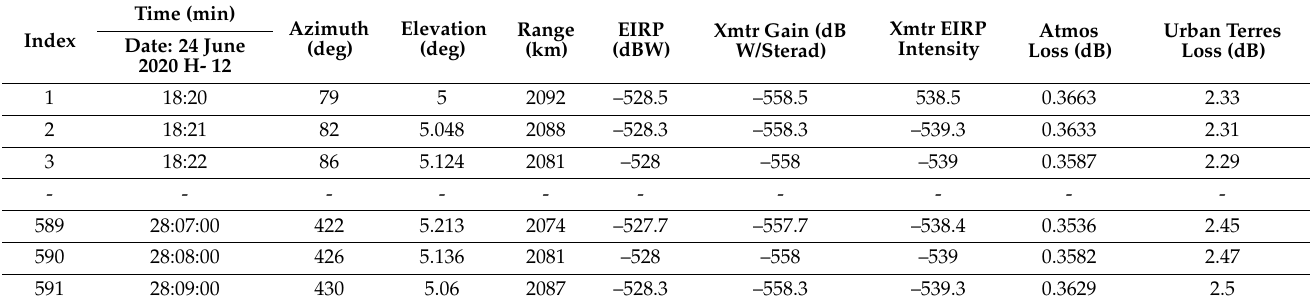
Table 3. Dataset records were used for our prediction experiment. Reprinted with permission from ref. [1]. Copyright 2021